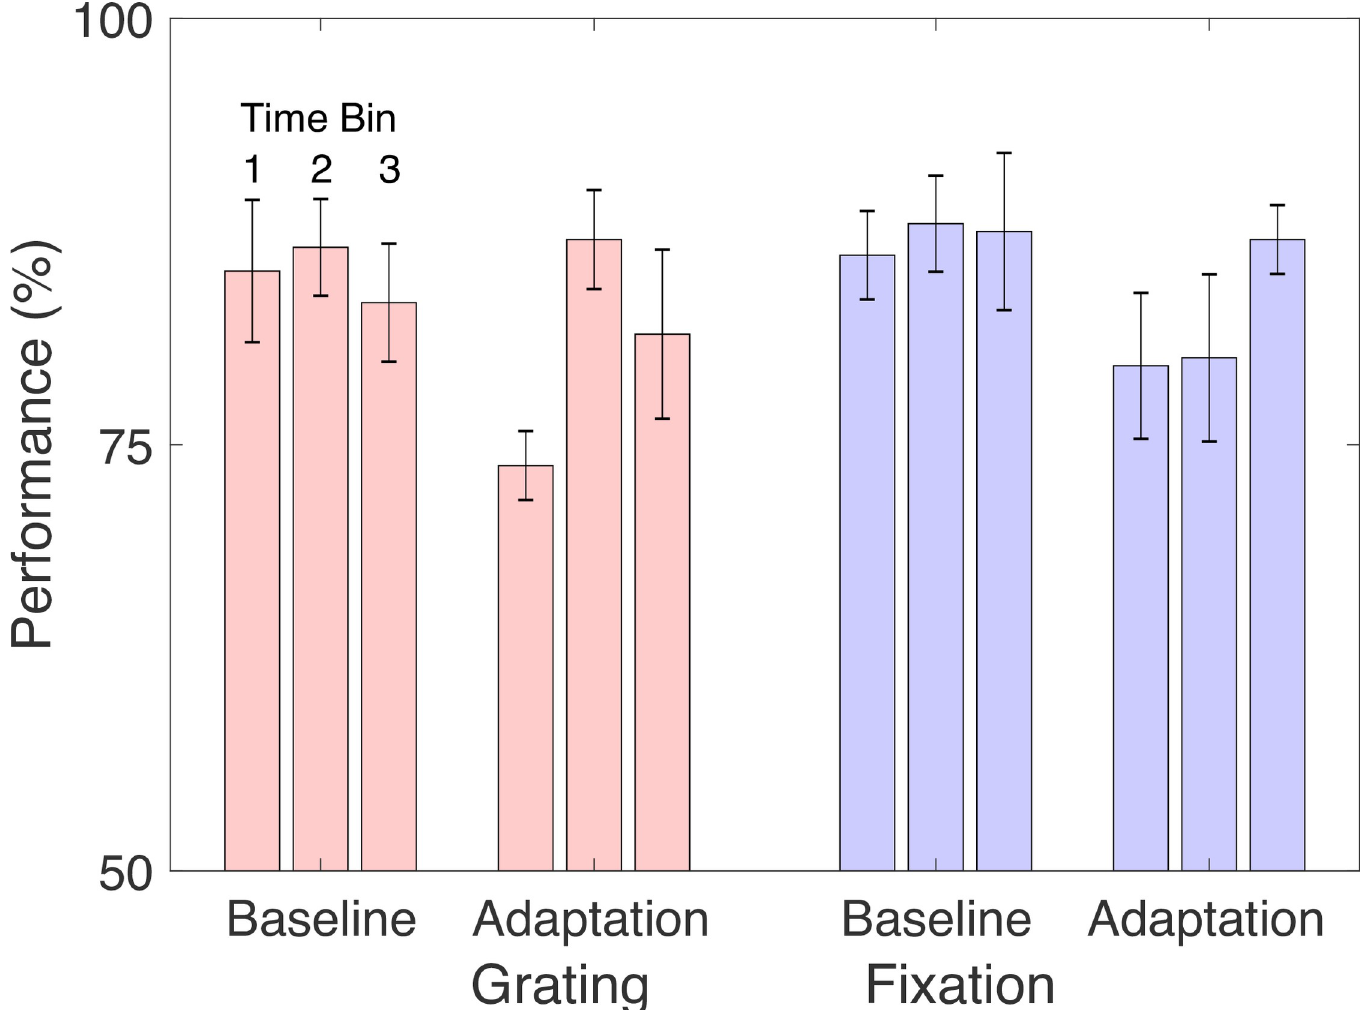
Fig 6. Performance on secondary tasks. Mean performance on the Grating Task and the Fixation Task shown during baseline (before adaptation) and following adaptation. Bars represent three 40-sec time bins over which performance was computed. Error bars represent +/- one SEM.